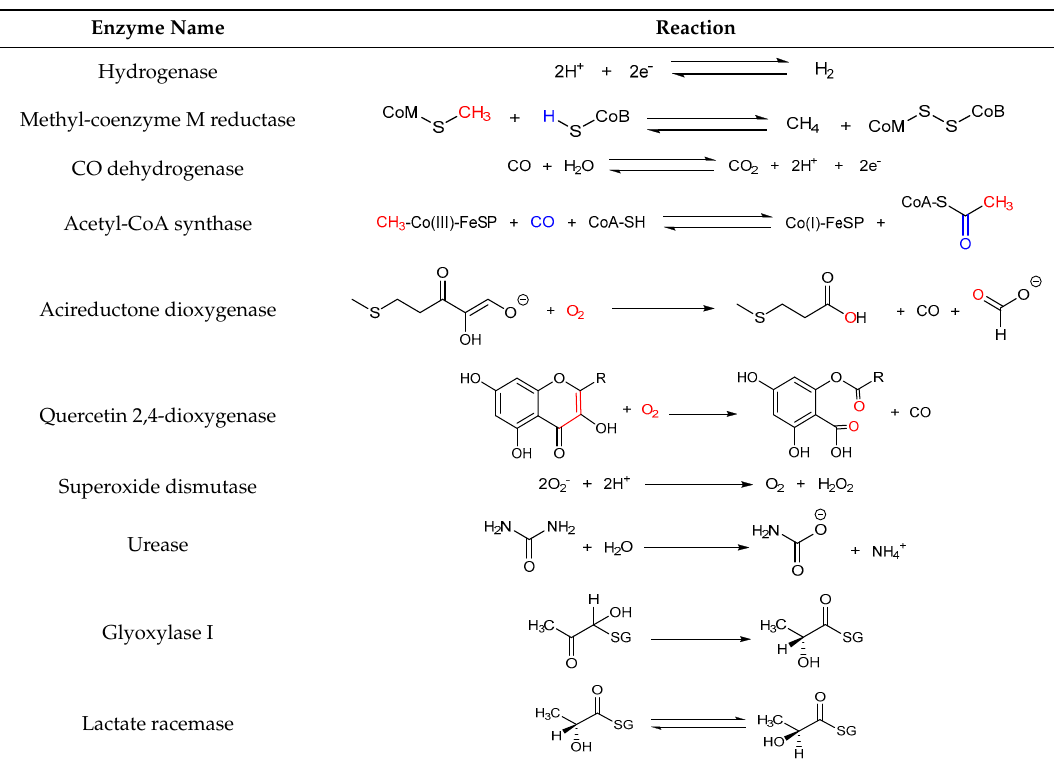
Table 1. Reactions catalyzed by Ni-dependent enzymes.